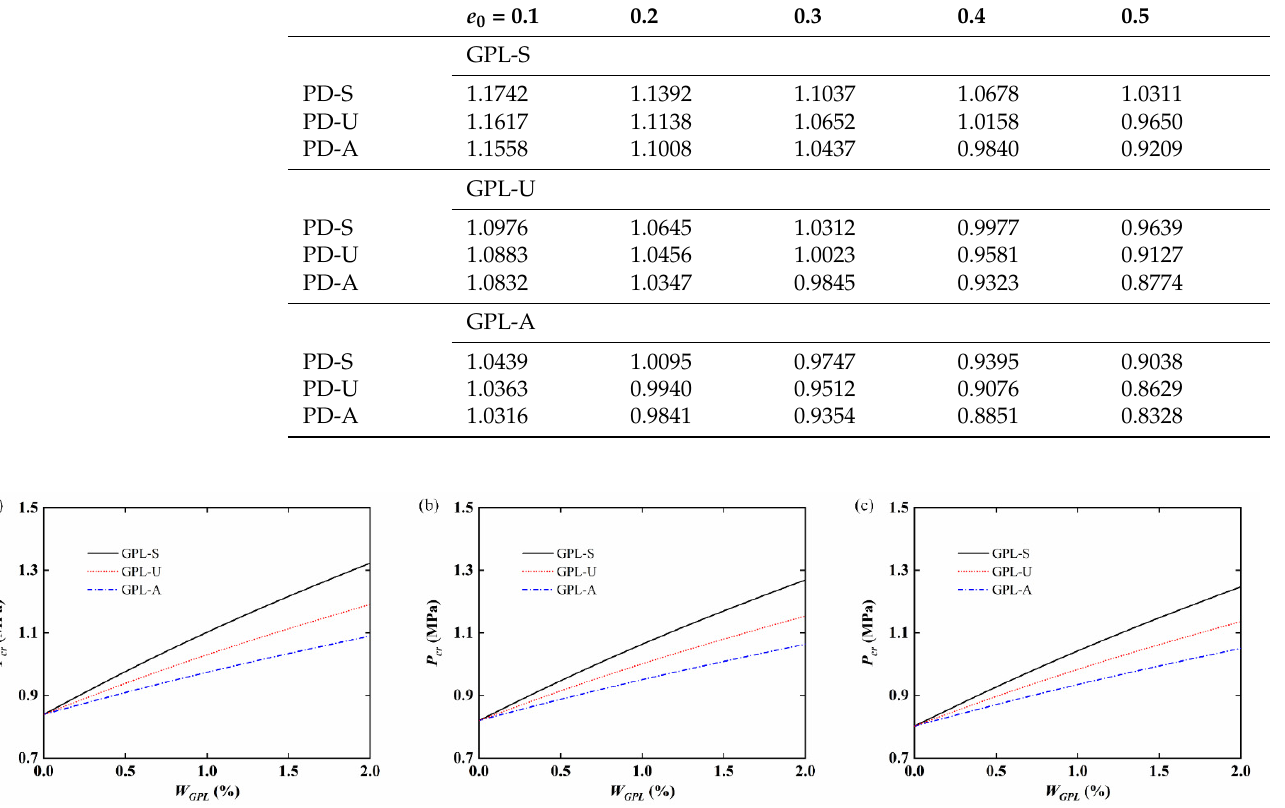
Table 4. Critical pressure of ring-stiffened porous GPLRC cylindrical shells for different porosity coefficients and porosity distributions.